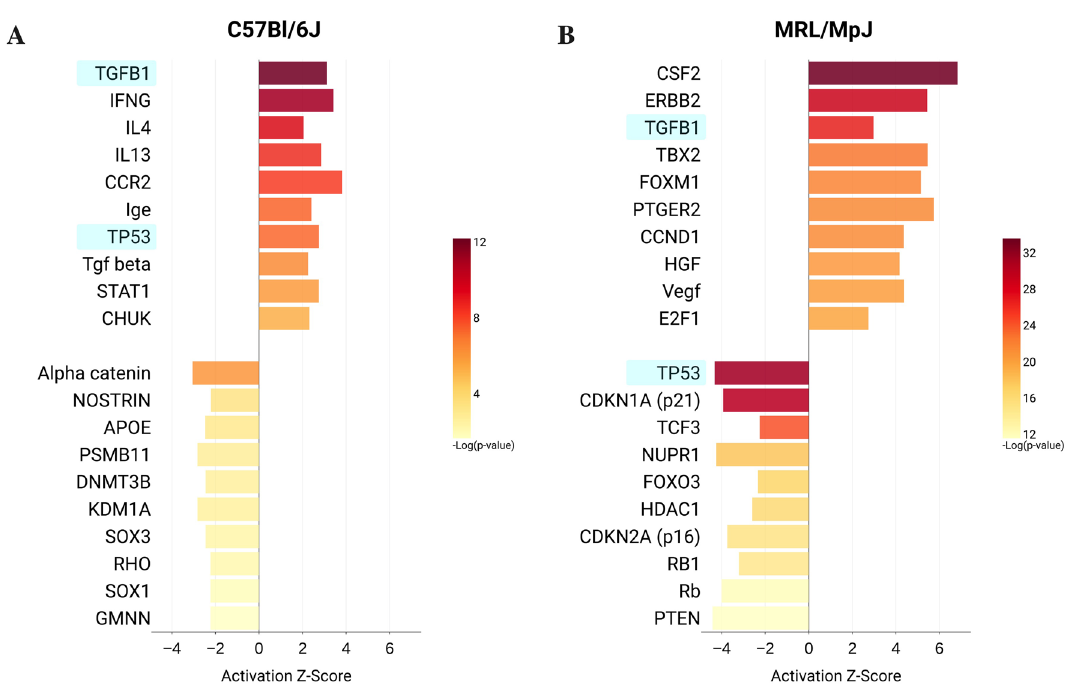
Figure 7. Ingenuity Pathway Analysis (IPA) Upstream Regulators during tendon healing in the C57 ( A ) and MRL ( B ) mice. Activation (Z-score ≥ 2, p value of overlap < 0.05) or inhibition (Z-score ≤ − 2, p value of overlap < 0.05) was determined relative to uninjured tendon gene expression in either